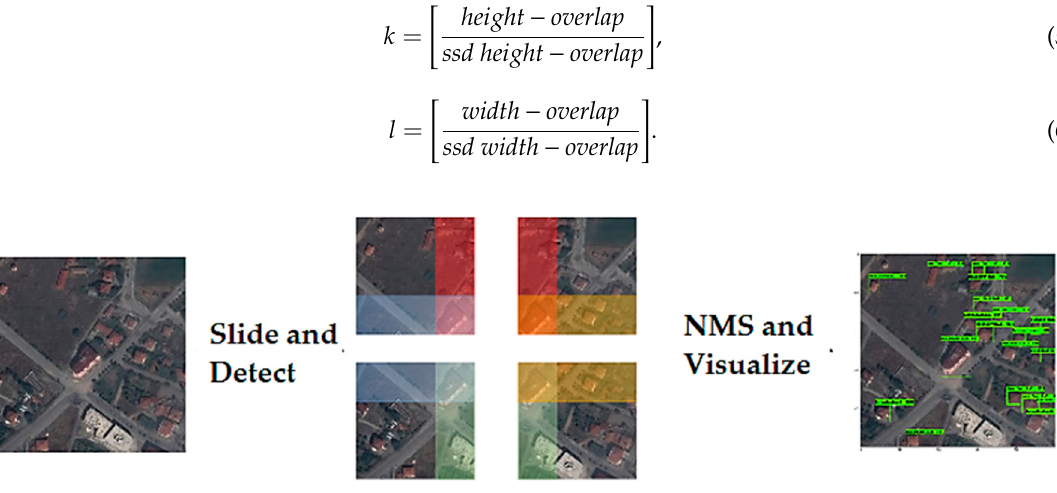
Figure 6. Process of the proposed detection flow of a 500 × 500 image with 100 pixels overlapping; the colored parts in the middle represents overlapping areas.